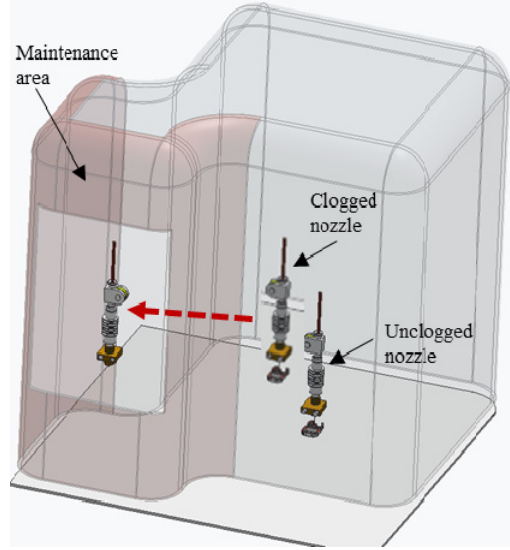
Figure 9. Structure of the proposed solution 2 Table 5. Comparing of the proposed solutions Solution Evaluation Degree of concepts Importance Time Usefulness